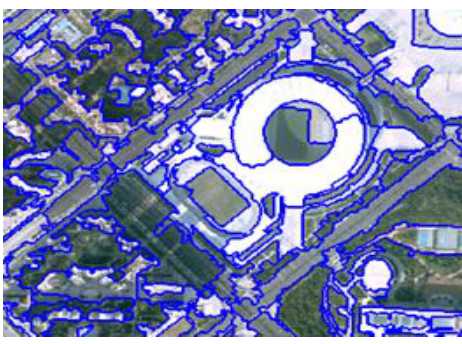
Figure 14. Multi-scale segmentation